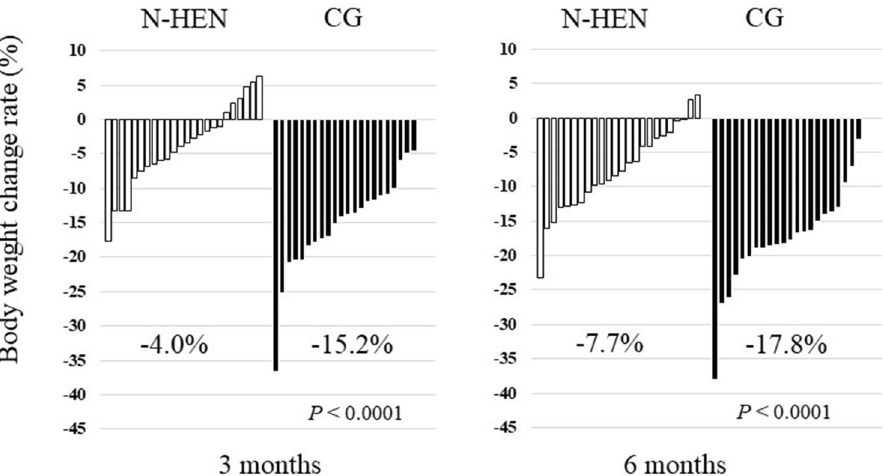
Figure 3. Waterfall plots of body weight change rate. After 3 and 6 months, patients with night home enteral nutrition (N-HEN) significantly presented less body weight loss than the control group (CG) (3 months P < 0.0001: N-HEN 4.0% vs. CG 15.2%, 6 months P < 0.0001: N-HEN 7.7% vs. CG 17.7%).